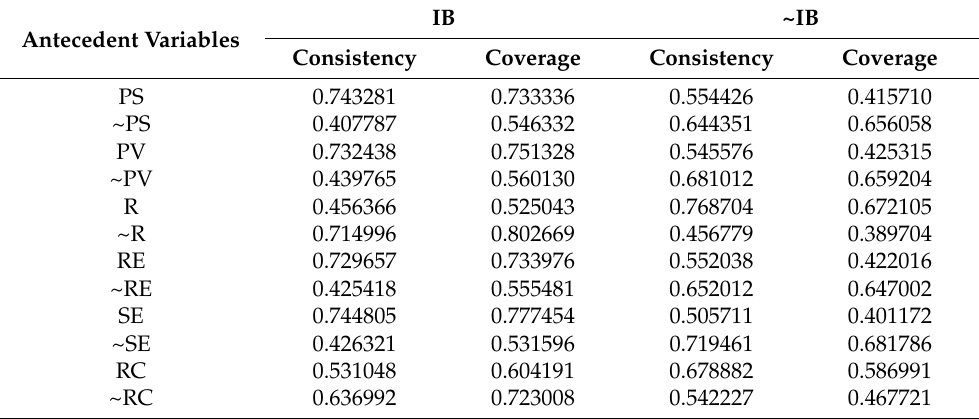
Table 6. Analysis of necessary